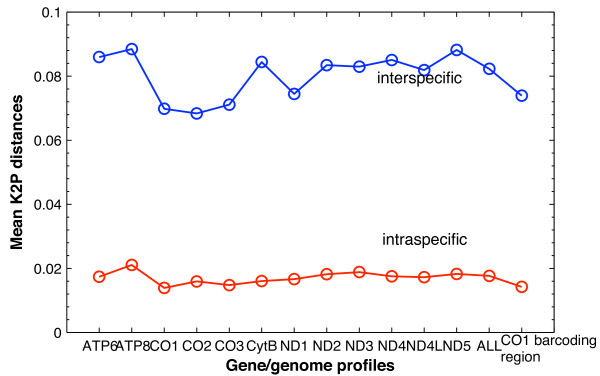
Mean intra- and interspecific distances from the 14 gene/genome profiles. Markers in red denote mean intraspecific distances, while those in blue denote mean interspecific distances. The 13 gene regions are listed on the x-axis, with the genome represented by "ALL".